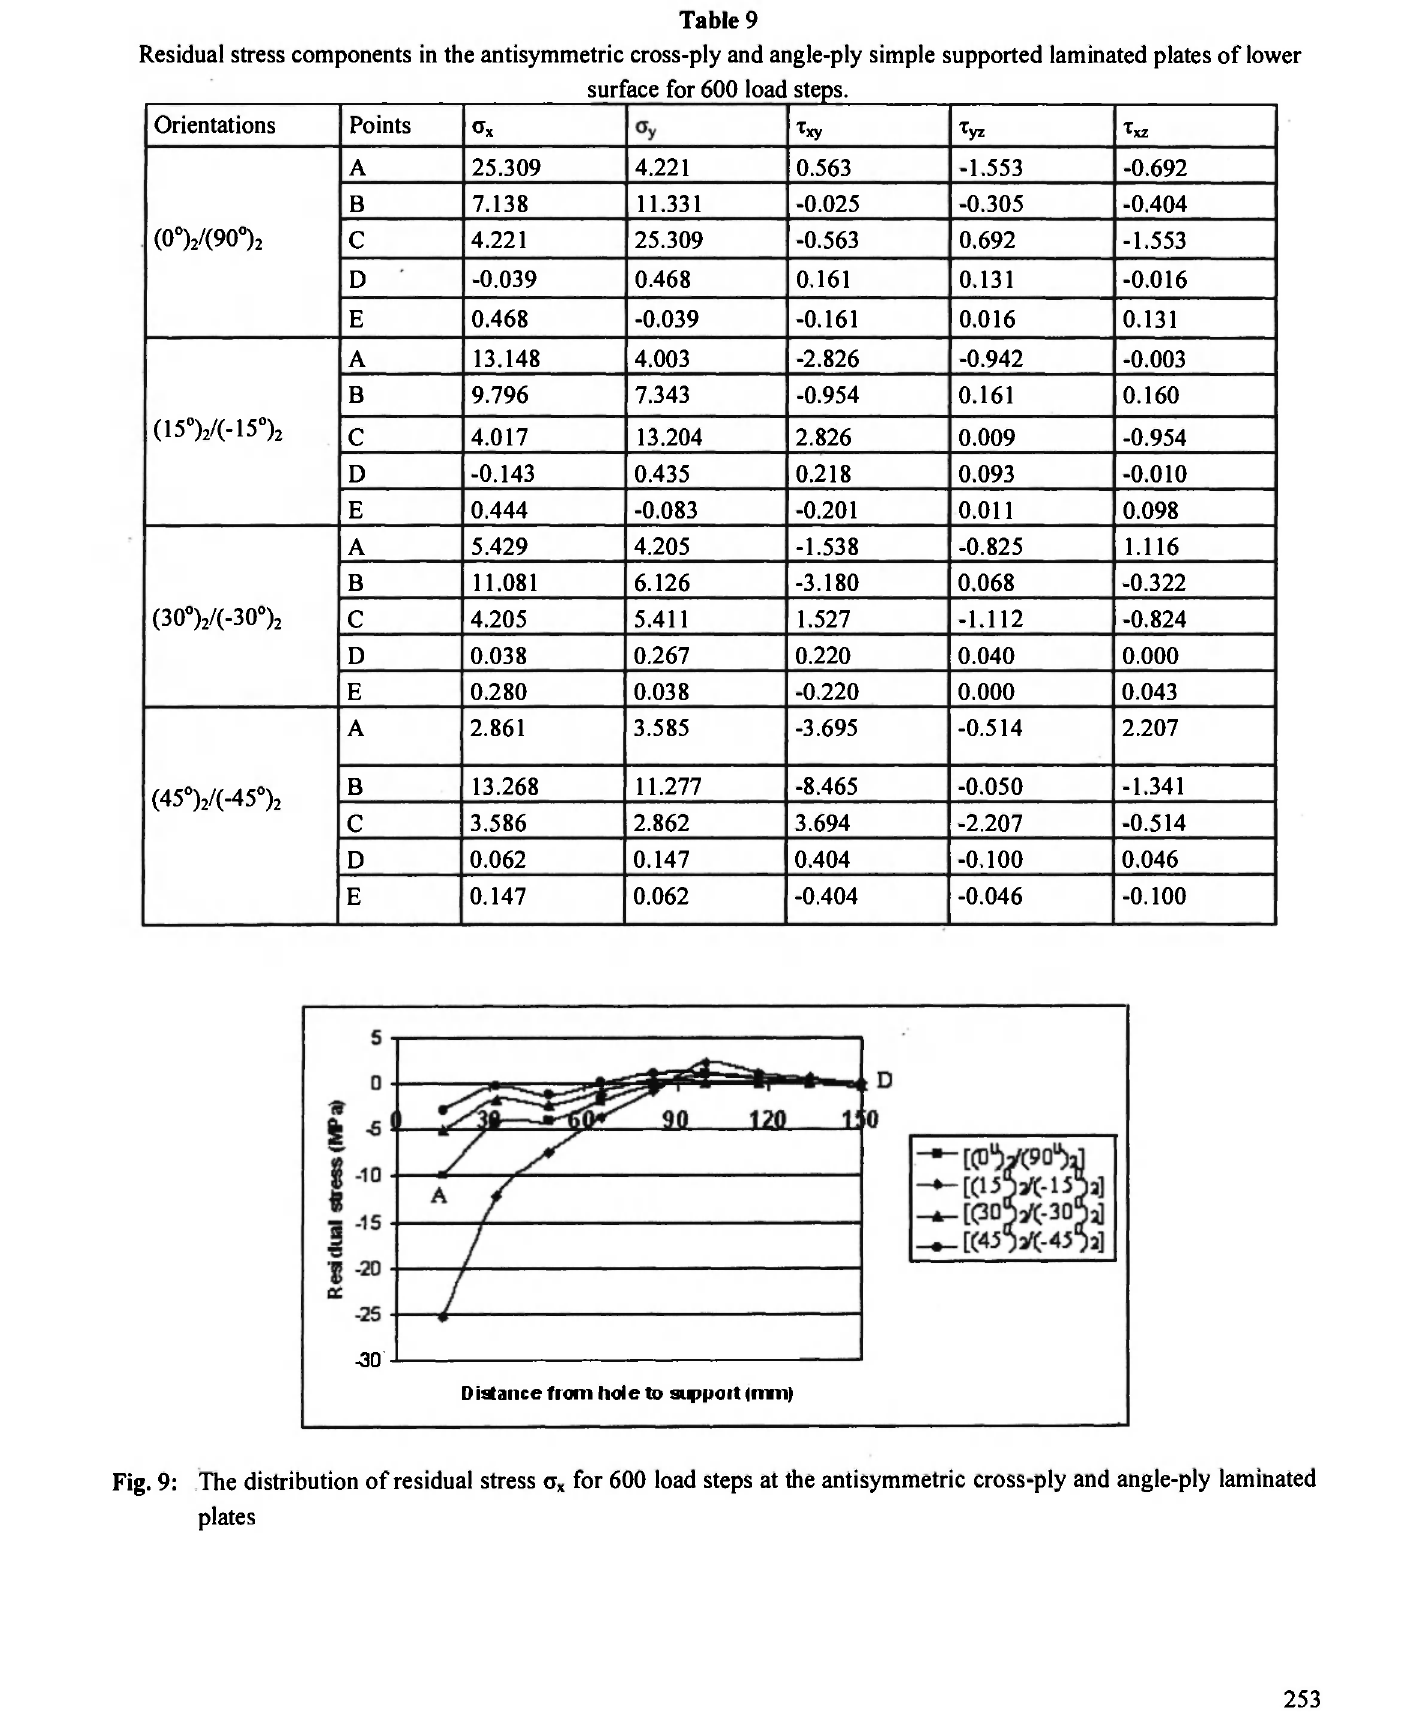
Residual stress components in the antisymmetric cross-ply and angle-ply simple supported laminated plates of lower surface for 600 load steps.